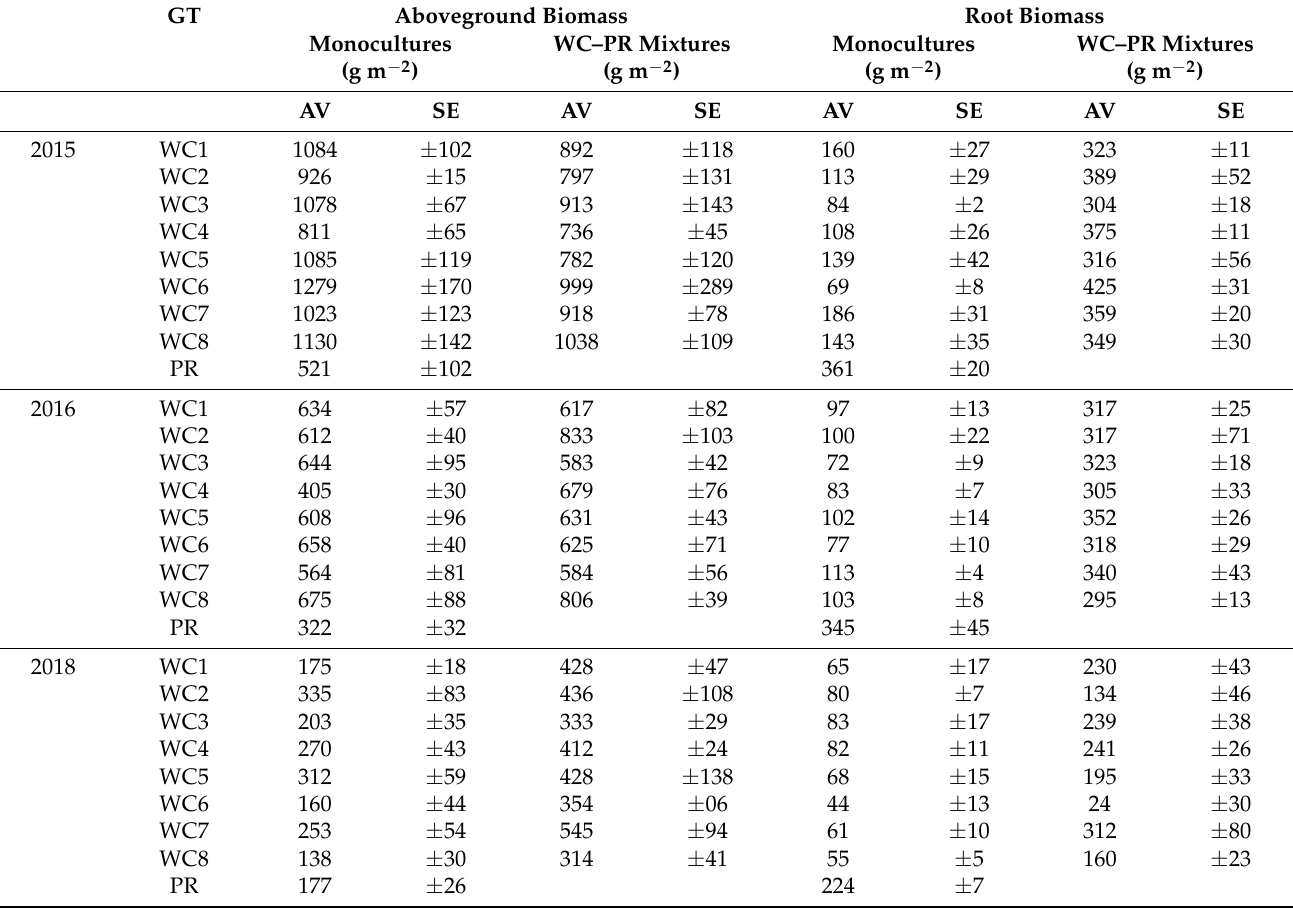
Figure A1. Precipitation and temperature at Goettingen (Reinshof) in 2015, 2016, and 2018. The figure shows monthly precipitation (mm) and temperature means ( ◦ C). Table A1. Average values and standard errors of aboveground biomass and root biomass ( n = 4) of white clover genotypes (GT) WC1–WC8 grown in monocultures and white clover (WC)–perennial ryegrass (PR) mixtures for 2015, 2016, and